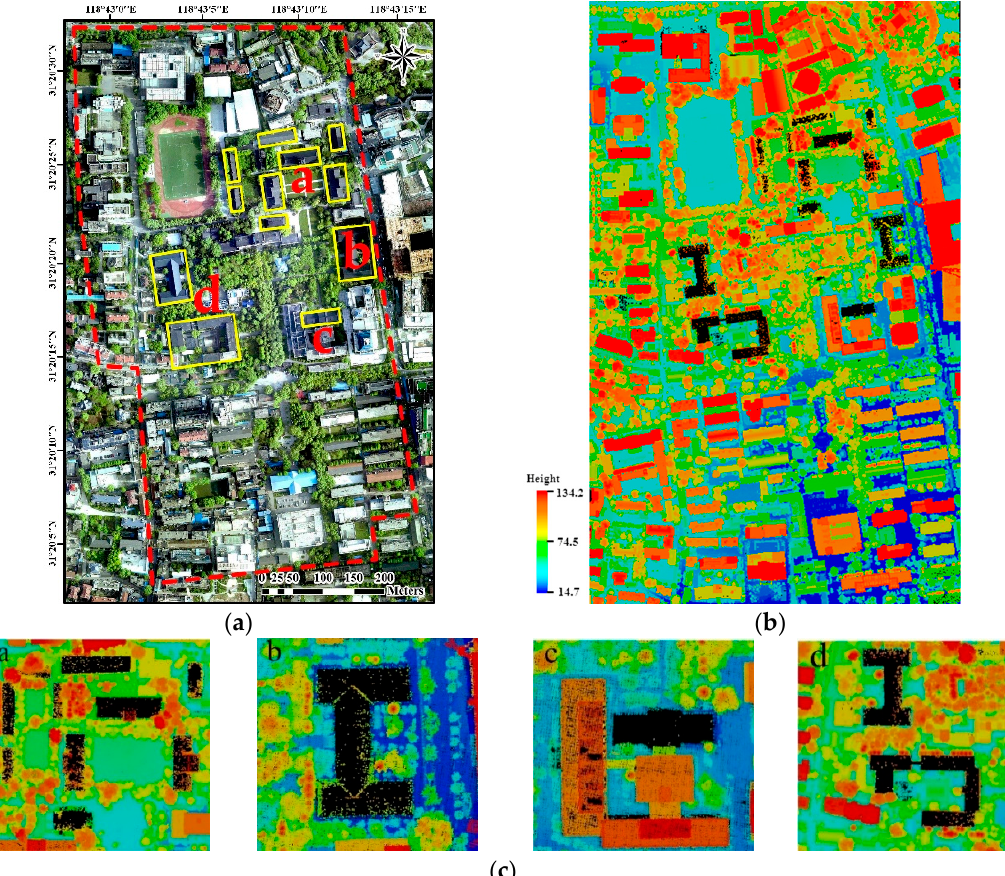
Figure 6. Experimental Region 1: ( a ) aerial orthophotos with 0.3 m resolution (no-data areas are shown by yellow boxes); ( b ) airborne LiDAR data; and( c ) no-data areas (black), corresponding the yellow boxes in ( a ) with letters.